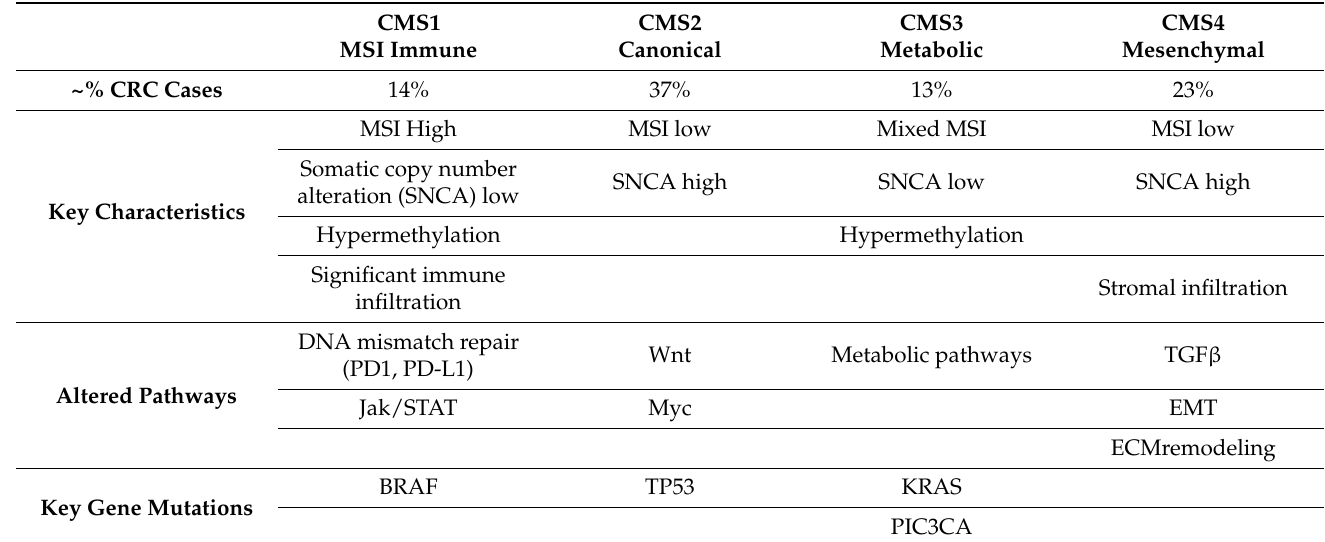
Table 1. CRC consensus molecular